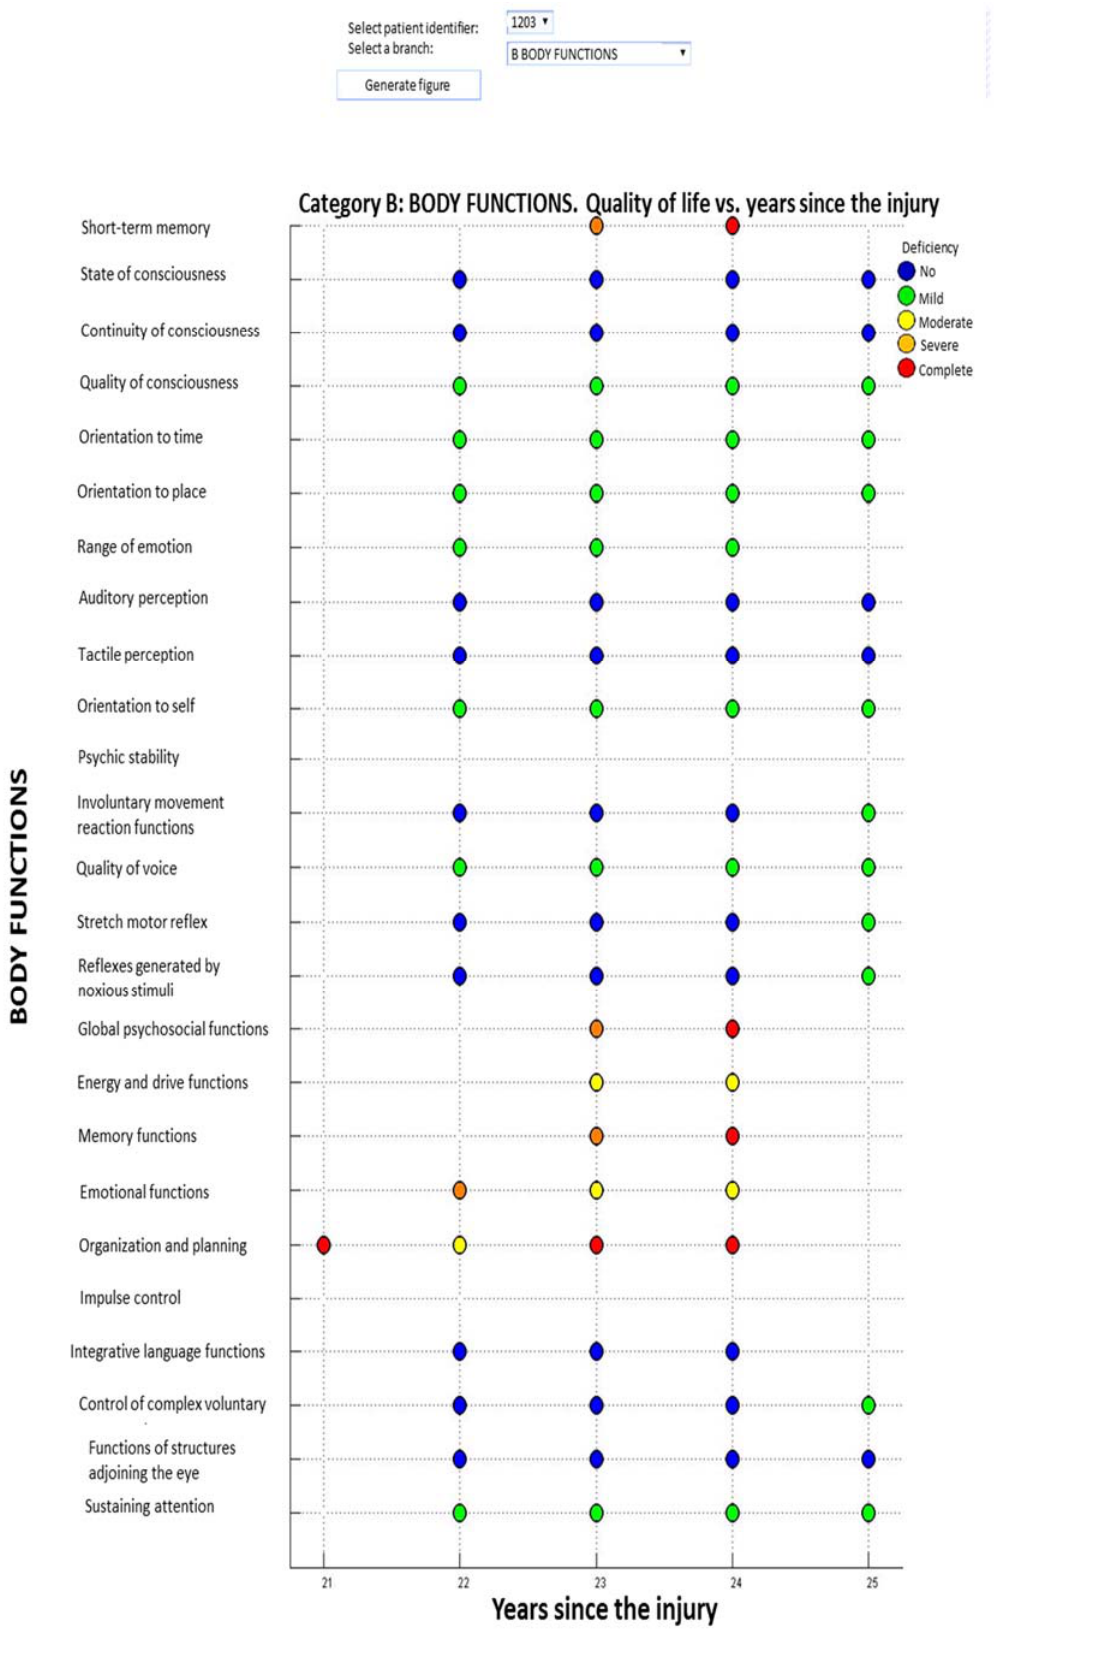
Figure 2. Graphical representation of the evolution of an individual through International Classification of Functioning, Disability and Health (ICF)